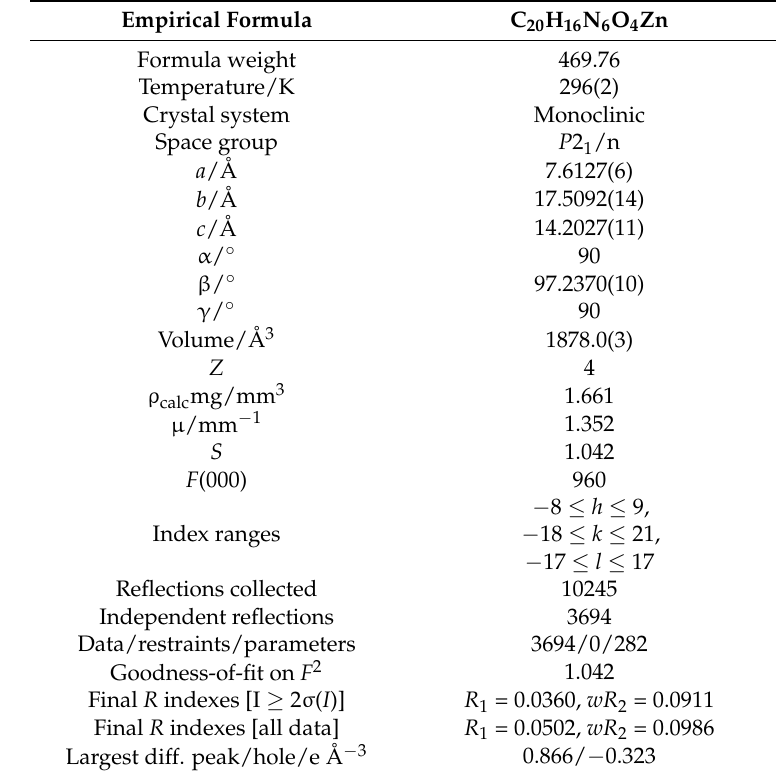
Table 1. Crystallographic data and structure refinement for 1